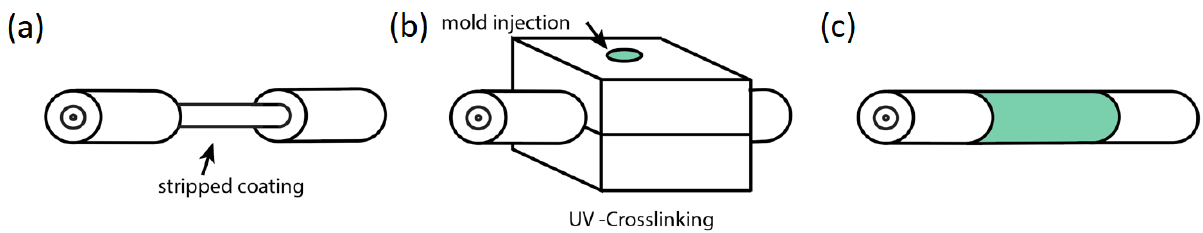
Figure 4. Steps to recoat optical fibers using a fiber recoater. ( a ) Stripping of polymer coating; ( b ) Polymer injection through a channel in the top plate into the mold assembly; ( c ) Recoated fiber via injection.